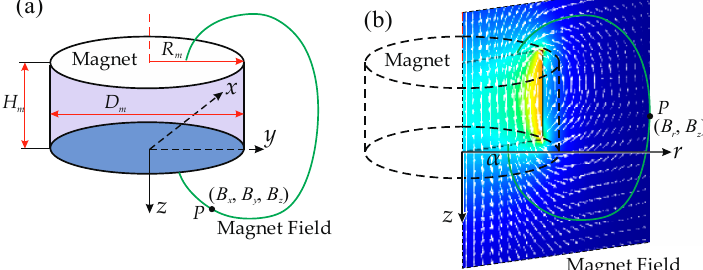
Figure 2. ( a ) A cylindrical permanent magnet and its magnetic field at point P in the Cartesian coordinate system; ( b ) The magnetic field vectors of the magnet in one axisymmetric plane and the magnetic field at point P in the cylindrical coordinate system.